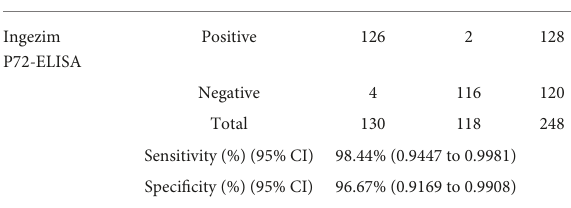
large-scale investigating field serum samples. As shown in Table 2 , the high agreement (97.6%, kappa = 0.9753) between the both methods was observed, and the p35-Luc LISA assay showed a relative sensitivity of 98.44% (95%